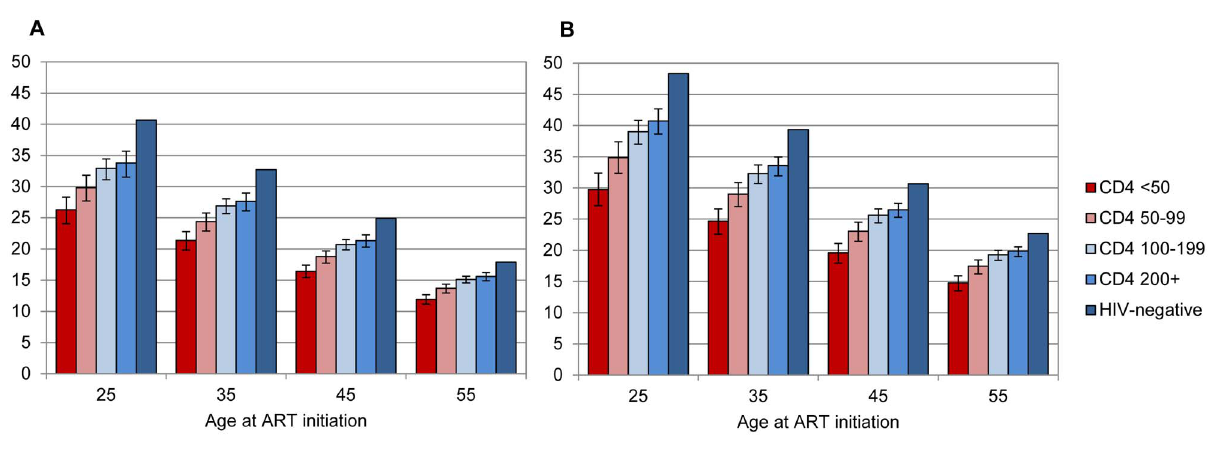
Figure 3. Life expectancies of patients with recorded ID, starting ART after 2006. Life expectancies are plotted by age at ART initiation and baseline CD4 count, for men (A) and women (B). Bars represent means, and error bars represent 95% confidence intervals.